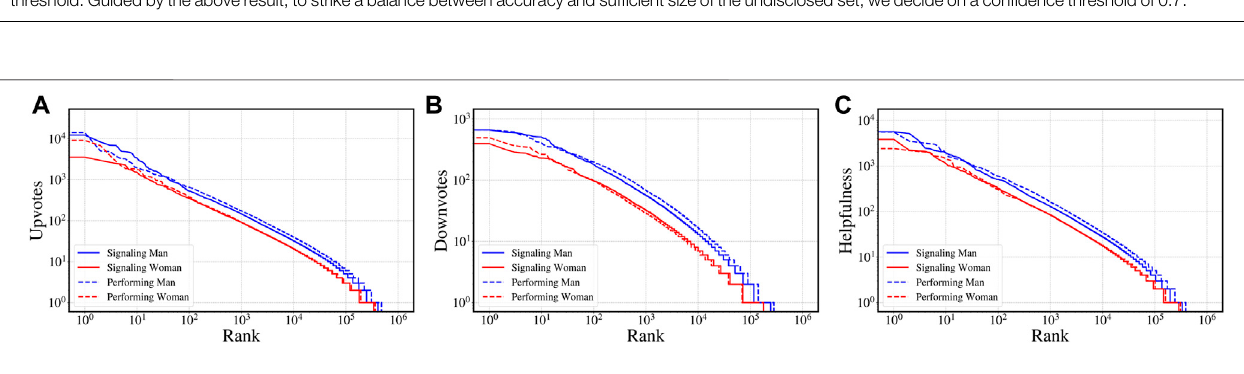
FIGURE 4 | Comparing perceived helpfulness. We sample 1 million reviews from each of the four categories and rank them based on upvotes, downvotes and helpfulness score (#upvotes - #downvotes). We plot the rank and the corresponding values of (A) upvotes, (B) downvotes and (C) helpfulness scores for the sampled reviews. On average reviews authored by signaling men tend to receive more upvotes as well as more downvotes. They are also perceived as more helpful on